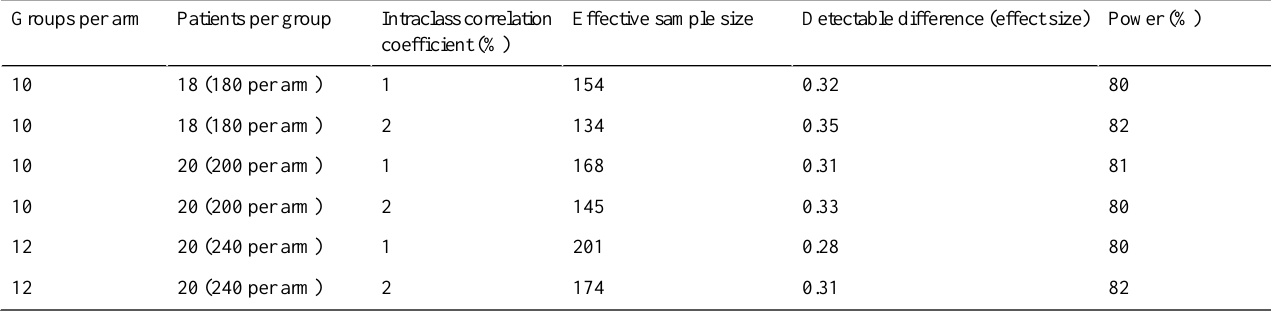
Table 2. Estimated power to detect treatment differences in percent weight